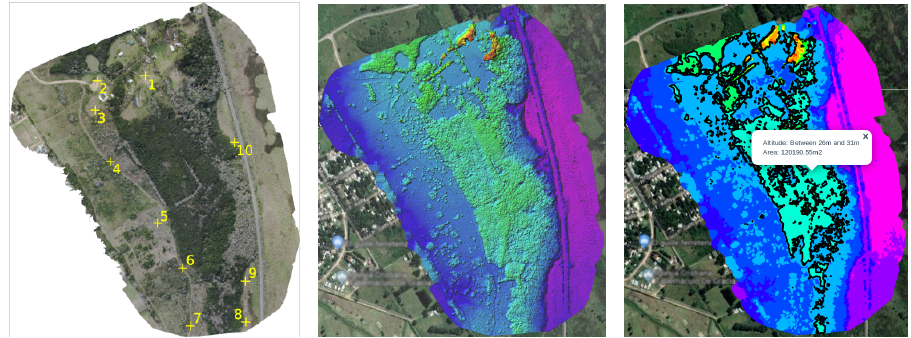
Figure 18. National Park Ciervo de los Pantanos. ( Left ): Orthomosaic generated, where yellow marks represents the CGPs. ( Medium ): corresponding height map. ( Right ): segmentation stratified by